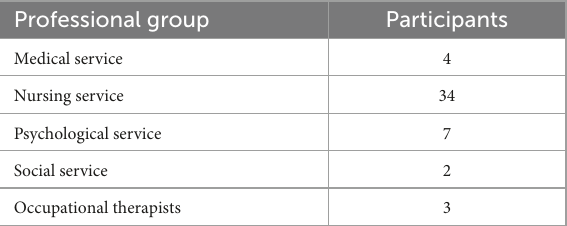
TABLE 1 Overview of participants in dependence on their occupation. Professional